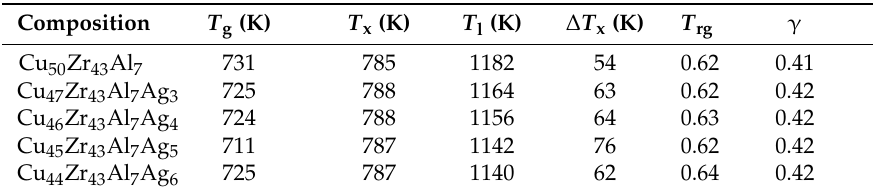
Table 1. Thermal parameters of the Cu 50 − x Zr 43 Al 7 Ag x ( x = 0, 3, 4, 5, 6) BMG alloys measured at a heating rate of 20 K/min.